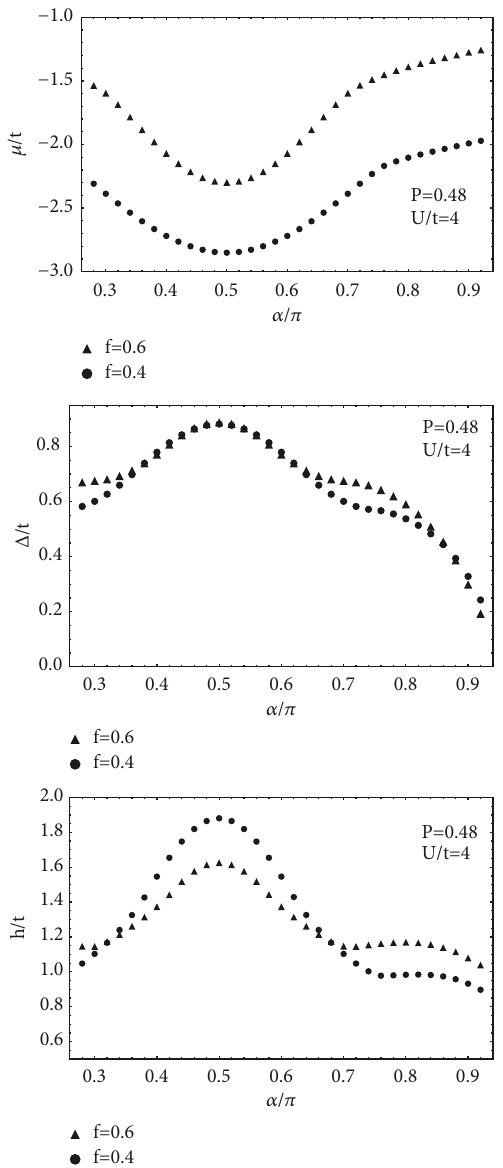
Figure 1: Chemical potential 𝜇 , pairing gap Δ , and the Zeeman field ℎ of a Fermi gas in a square optical lattice subject to a non-Abelian gauge field A = (𝛼𝜎 푦 , −𝛼𝜎 푥 ) . The graphs are obtained by solving the mean field equations (13)-(17) using two different filling factors: 𝑓 = 0.4 and 𝑓 = 0.6 . The on-site attractive strength is 𝑈 = 4𝑡 , and the polarization is 𝑃 = 0.48